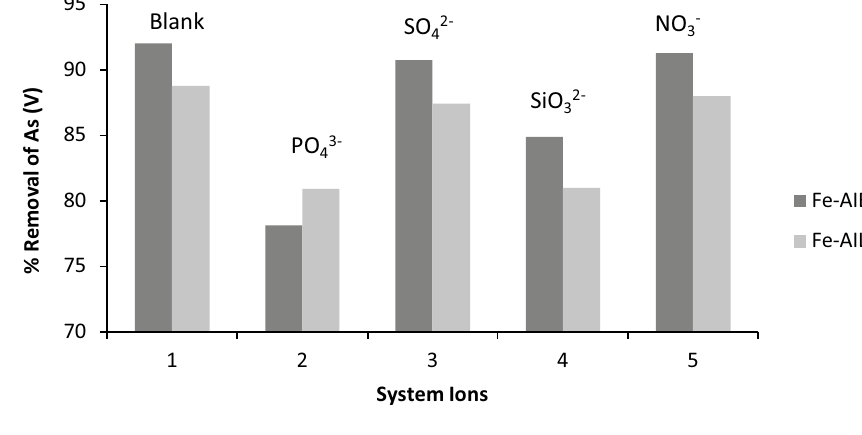
Fig. 15 Effect of co-existing ions on the adsorption of As(V). (Experiment conditions: initial As(V) concentration 100 μg/L, adsorbent dosage 1.0 g/L, solu- tion pH 6.0, agitation speed 60